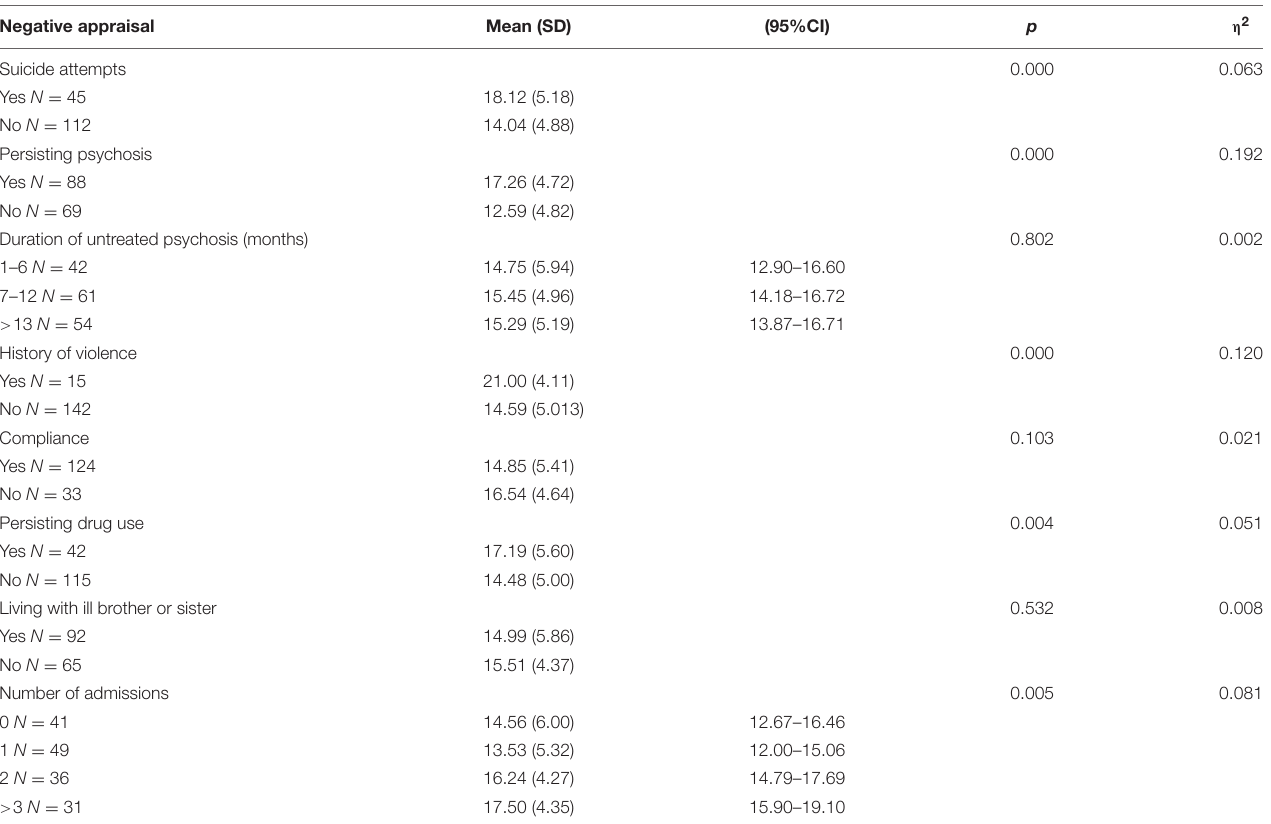
TABLE 6 | The experience of caregiving and illness related variables of